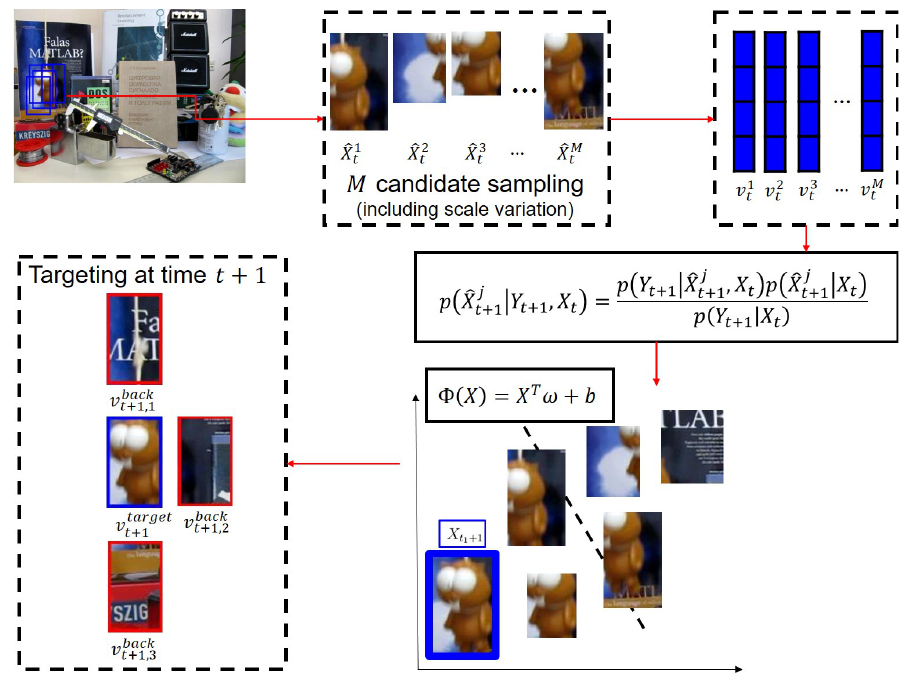
Figure 2. Representation of the target object using structured sparse PCA and deterministic classification between the target object and background image